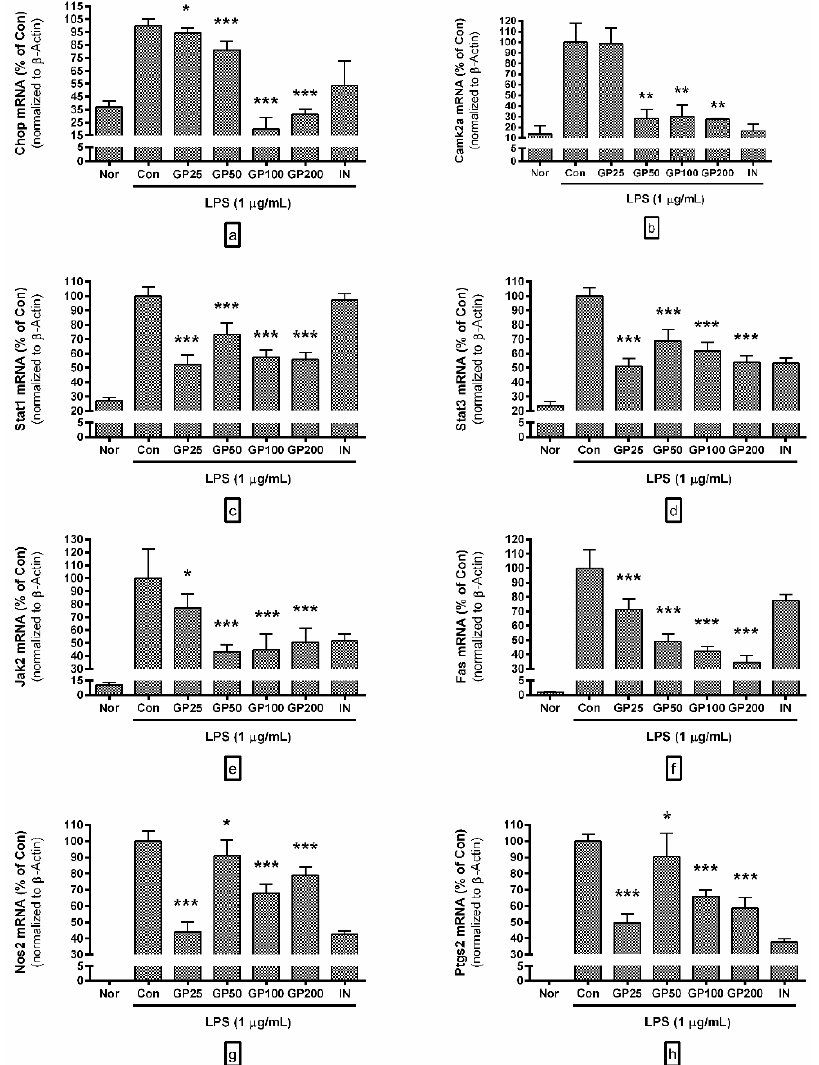
Figure 3. Effects of a combination extract of Gardeniae Fructus and Perillae Folium (GP) on mRNA expressions of Chop (NM_007837) ( a ), Camk2a (NM_012920) ( b ); Stat1 (NM_009283.4) ( c ); Stat3 (NM_213659.2) ( d ); Jak2 (NM_008413) ( e ); Fas (NM_007987) ( f ); Nos2 (NM_010927.3) ( g ), and Ptgs2 (NM_011198) ( h ) in LPS-activated RAW 264.7. mRNA expressions were evaluated by real-time quantitative PCR. β -Actin was used as an internal control. Values are the mean ± SD of the three independent experiments. Nor, normal group (media only); Con, control group (LPS alone); IN, indomethacin (0.5 µM). GP25, GP50, GP100, and GP200 indicate 25, 50, 100, and 200 µg/mL of GP, respectively. * p < 0.05 vs. Con; ** p < 0.01 vs. Con; *** p < 0.001 vs. Con.